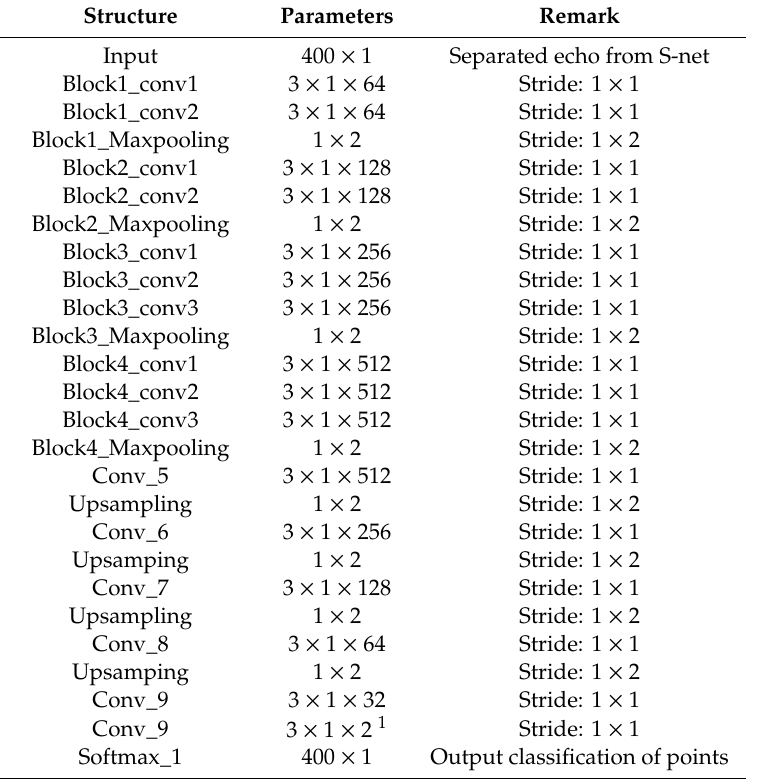
Table 2. Specific structure of